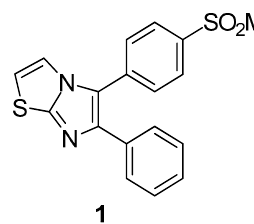
Figure 2. Chemical structure of 5,6-diarylimidazo[2.1- b ]thiazole derivative 1 .